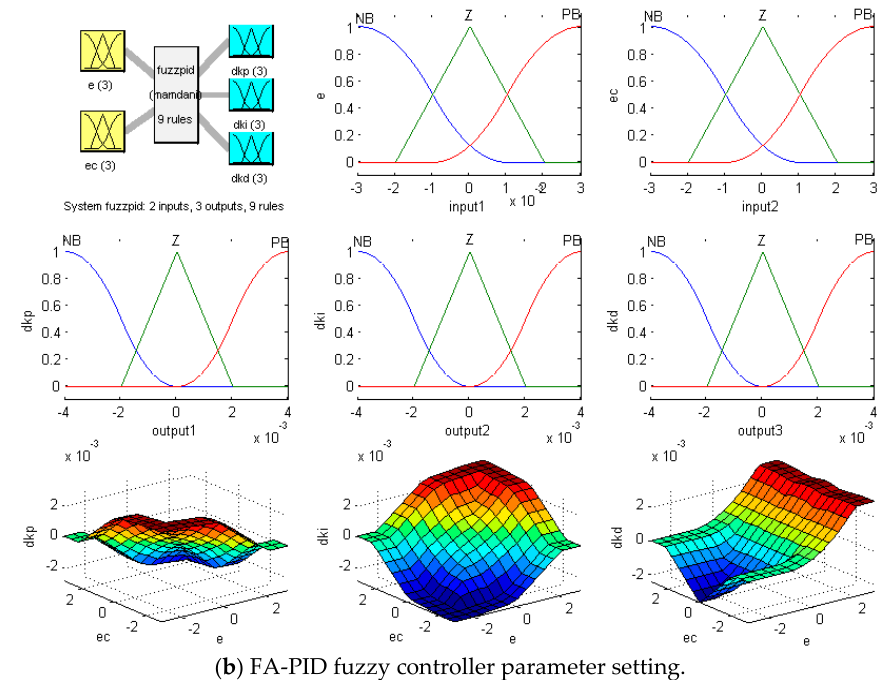
Figure 5. Design of fuzzy controller: ( a ) F-PID fuzzy controller parameter setting; ( b ) FA-PID fuzzy controller parameter setting.